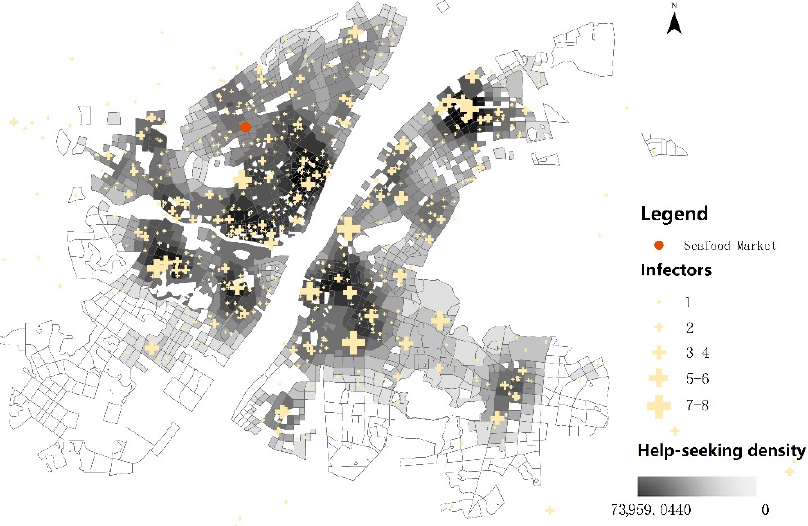
Figure 2. Density map of Weibo help data.